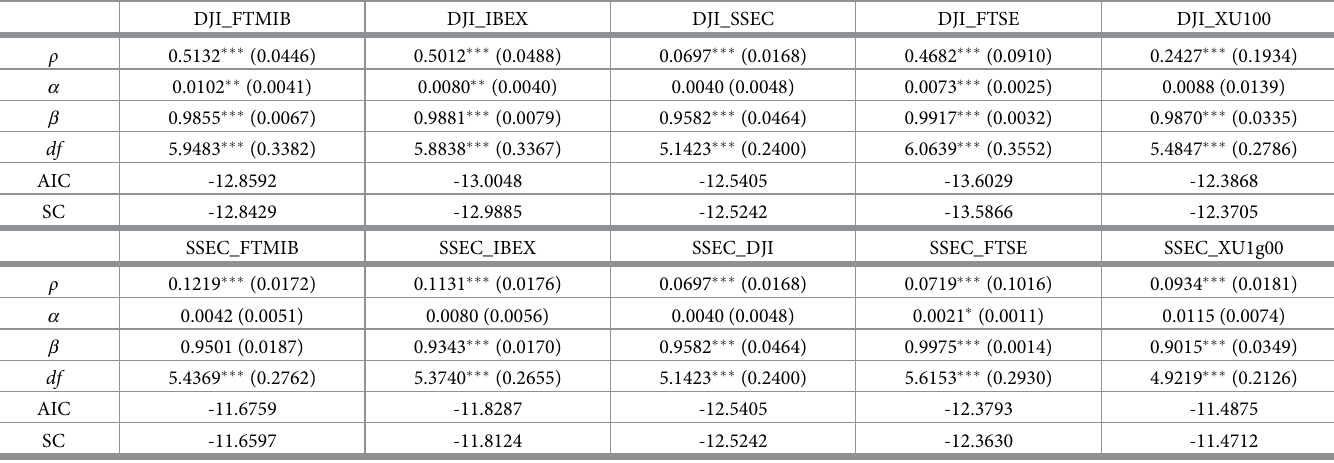
Table 4. Dynamic conditional correlation GARCH model